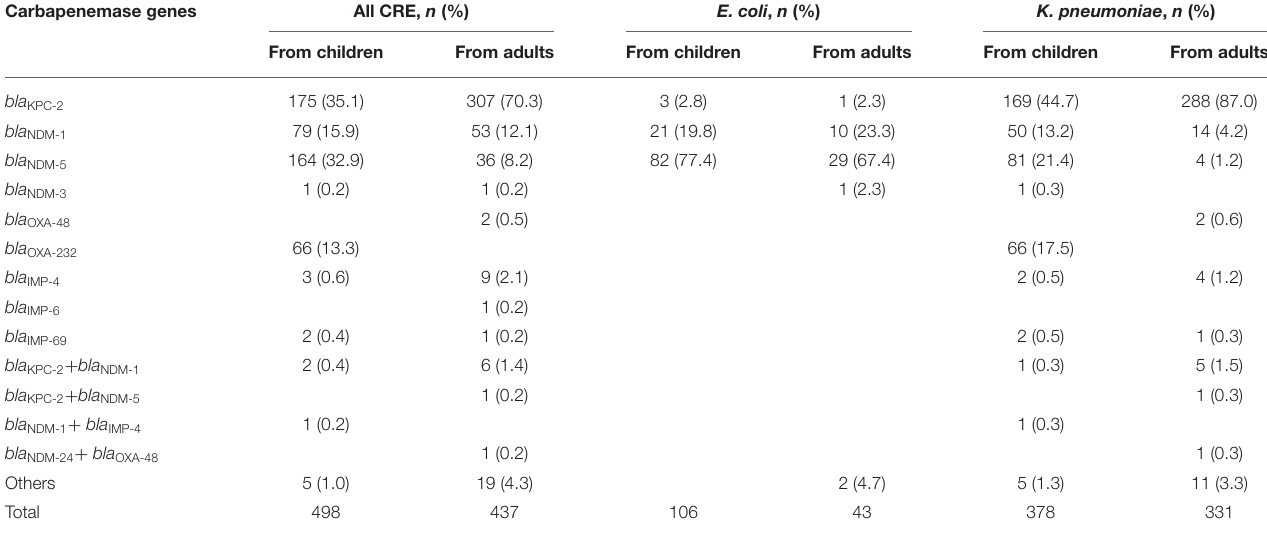
TABLE 3 | Distribution of different carbapenemase genes in 935 CRE strains isolated from adults and children patients. Carbapenemase genes All CRE, n (%) E. coli , n (%) From adults From children From adults From